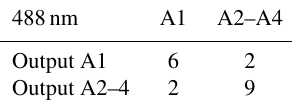
Table 5. Output of the wood category identification for 488nm.